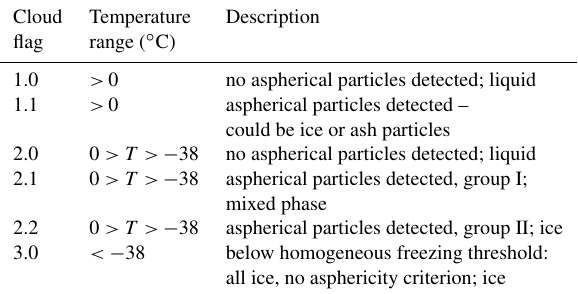
Table 2. Cloud flag description of the NIXE-CAPS asphericity product after Costa et al. (2017). Group I: total concentration of par- ticles 3–50µm is larger than 3cm − 3 . Group II: total concentration of particles 3–50µm is smaller than 1cm − 3 and total concentration of particles with size larger than 50µm is larger than 0cm − 3